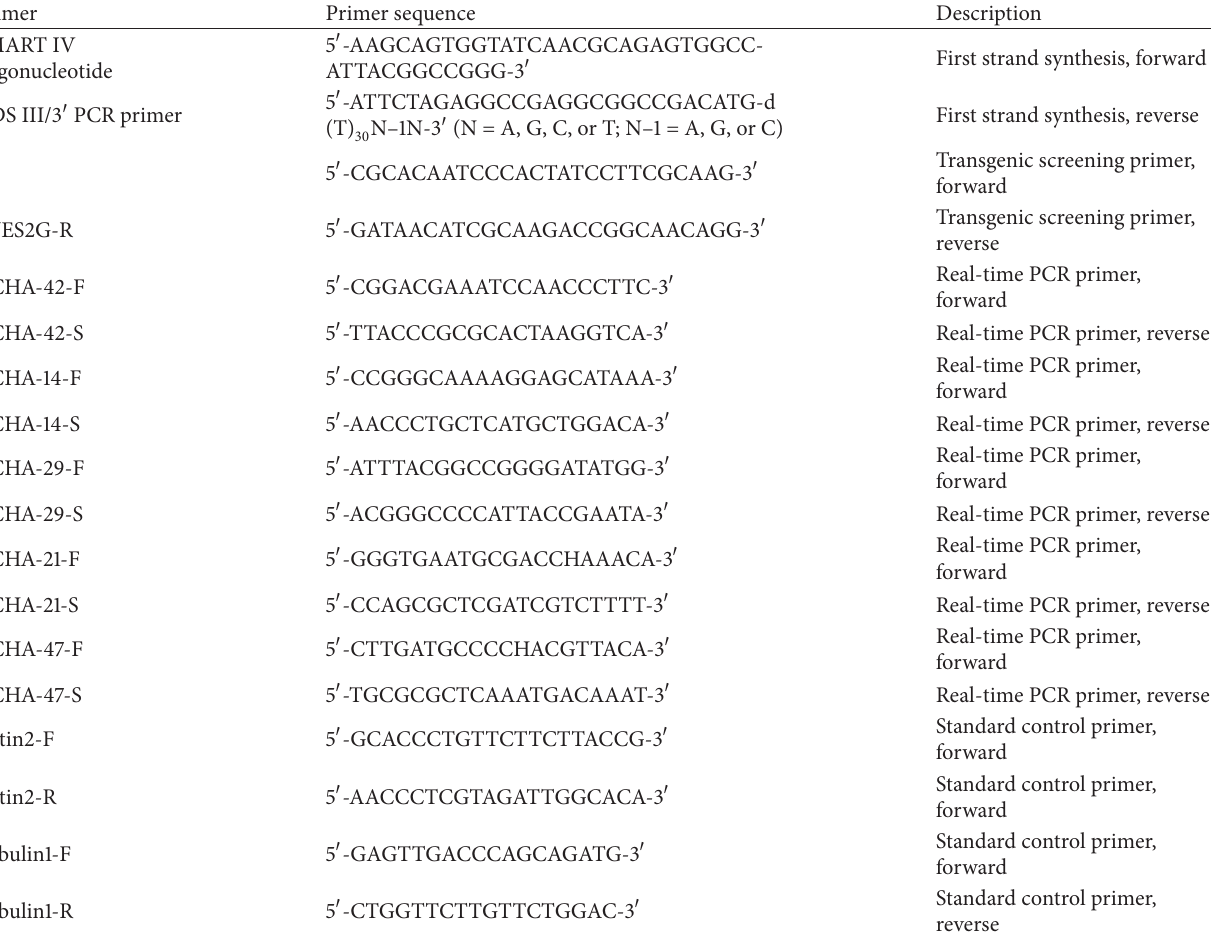
Table 1: Primers used in this